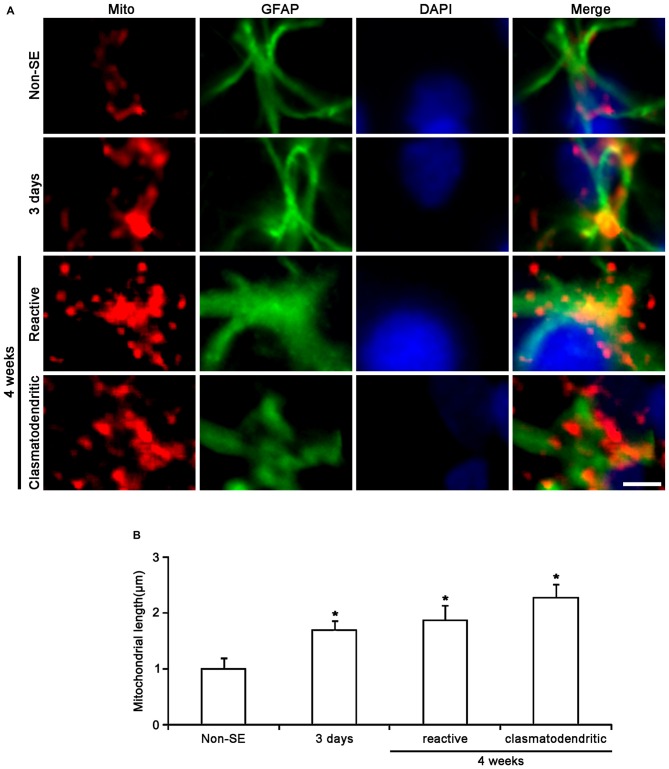
Change in mitochondrial morphology in astrocytes within the CA1 region. (A) As compared to non-SE animals, mitochondrial length is increased 3 days after SE. Four weeks after SE, mitochondrial length is increased and the morphology of mitochondria is sphere shaped in reactive astrocytes as well as clasmatodendritic astrocytes. Bar = 3.75 μm. (B) Quantitative values (mean ± SEM) of mitochondrial length in the CA1 region (n = 7, respectively). *p < 0.05 vs. non-SE animals.